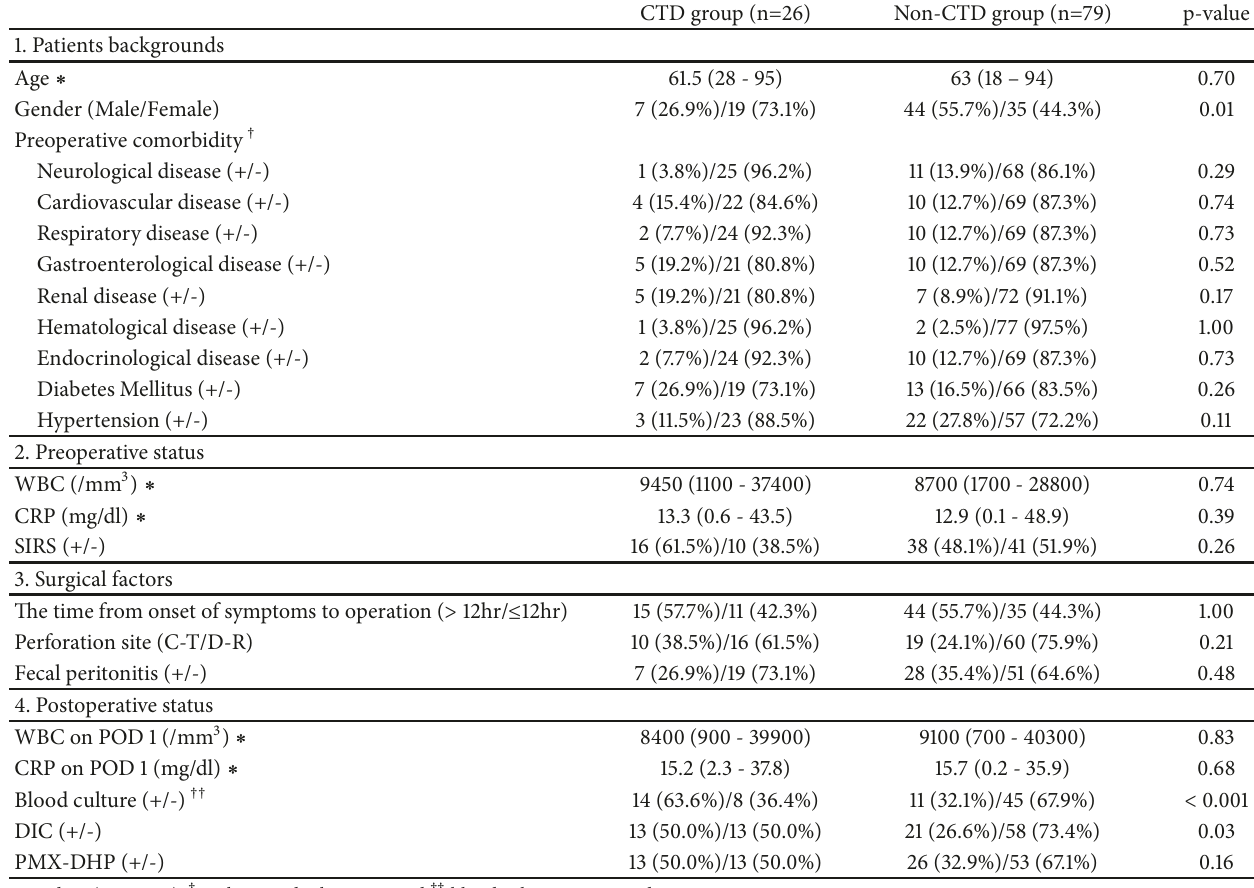
Table 4: Clinicopathological factors in patients with and without connective tissue disease